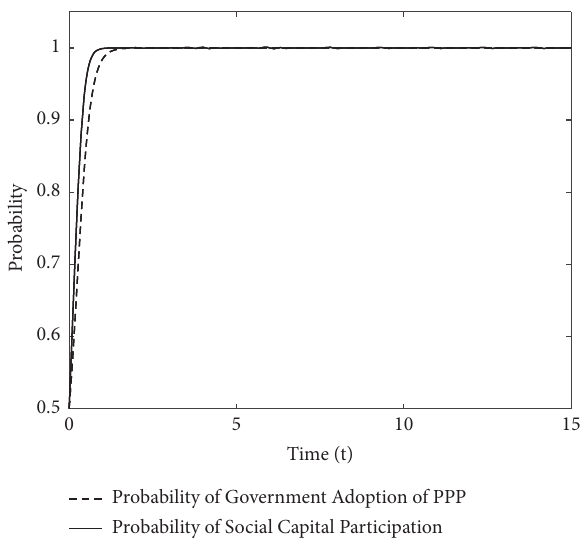
Figure 2: The evolution path of the stable strategy for the